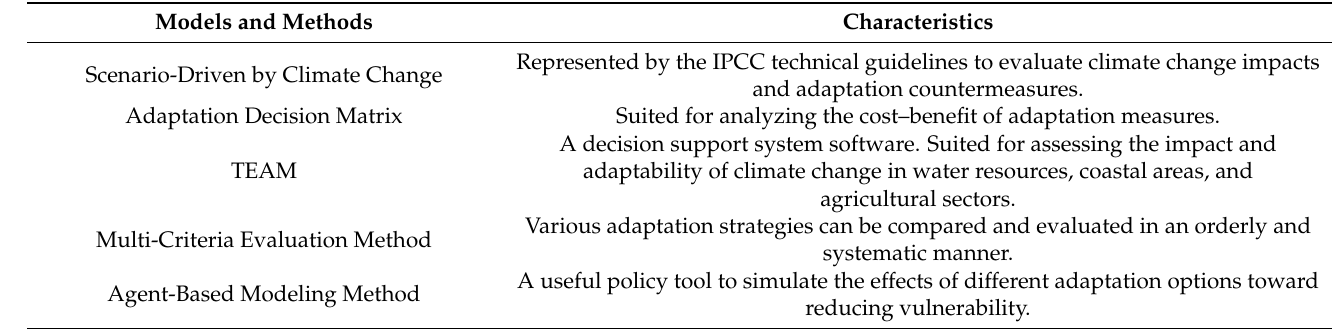
Table 2. An overview of analysis models and methods of adaptation. Models and